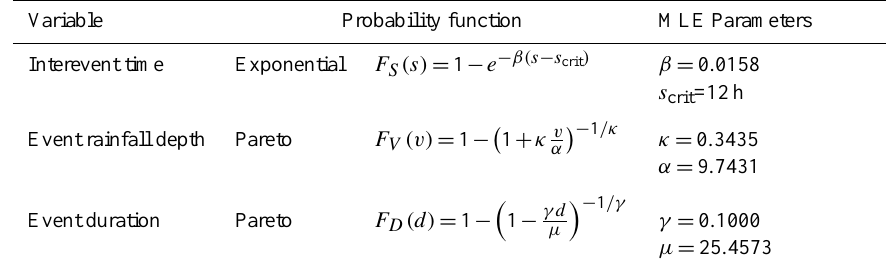
Table 5. Distribution functions and related MLE parameters for rainfall descriptors estimated for Santander raingauge.